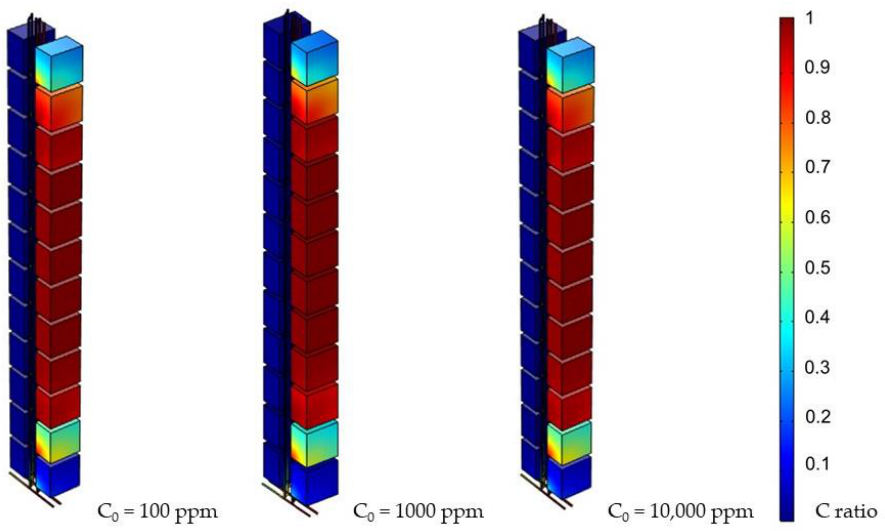
Figure 9. Simulation results for various C 0 (day 3, 0.05 Pa). Figure 10 indicates how environmental temperature influenced the system under three different atmospheric temperatures in different seasons. It shows that different environmental temperatures did not result in significant system reactions.